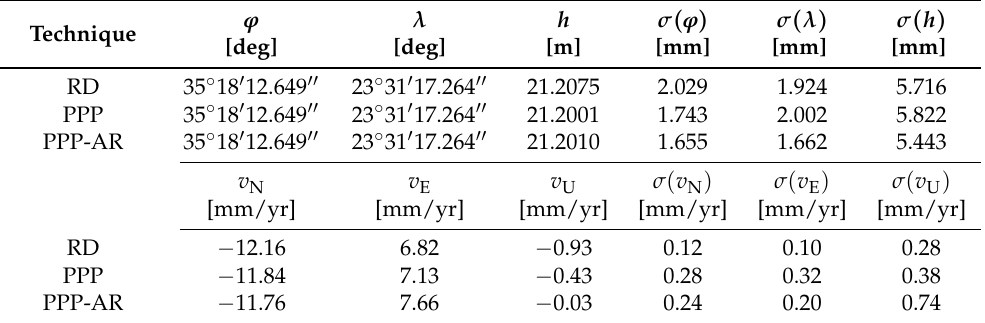
Table 3. Absolute positioning and velocity results for the CRS1 permanent GNSS station, as derived by different techniques: RD: Relative Differential; PPP: Precise Point Positioning; PPR-AR: Precise Point Positioning with ambiguity resolution (Reference epoch: 2013.5, Reference frame: